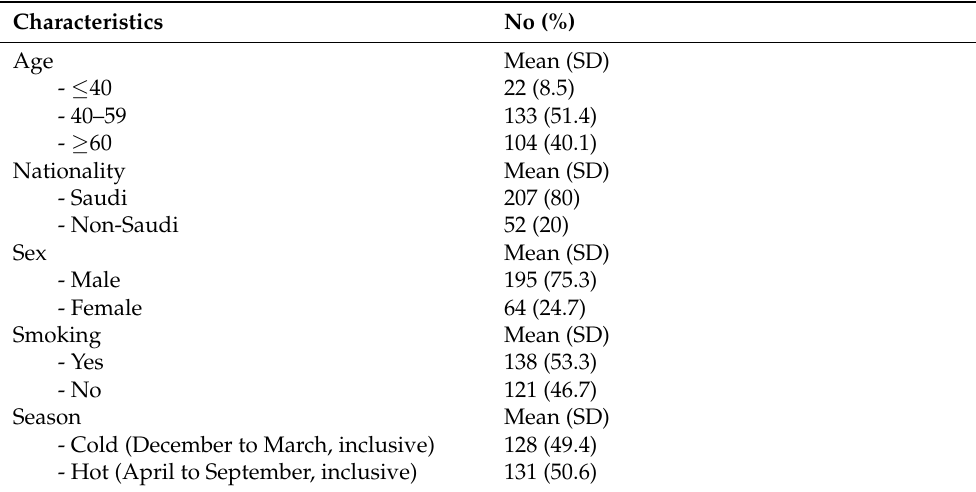
Table 1. Study population characteristic ( n =